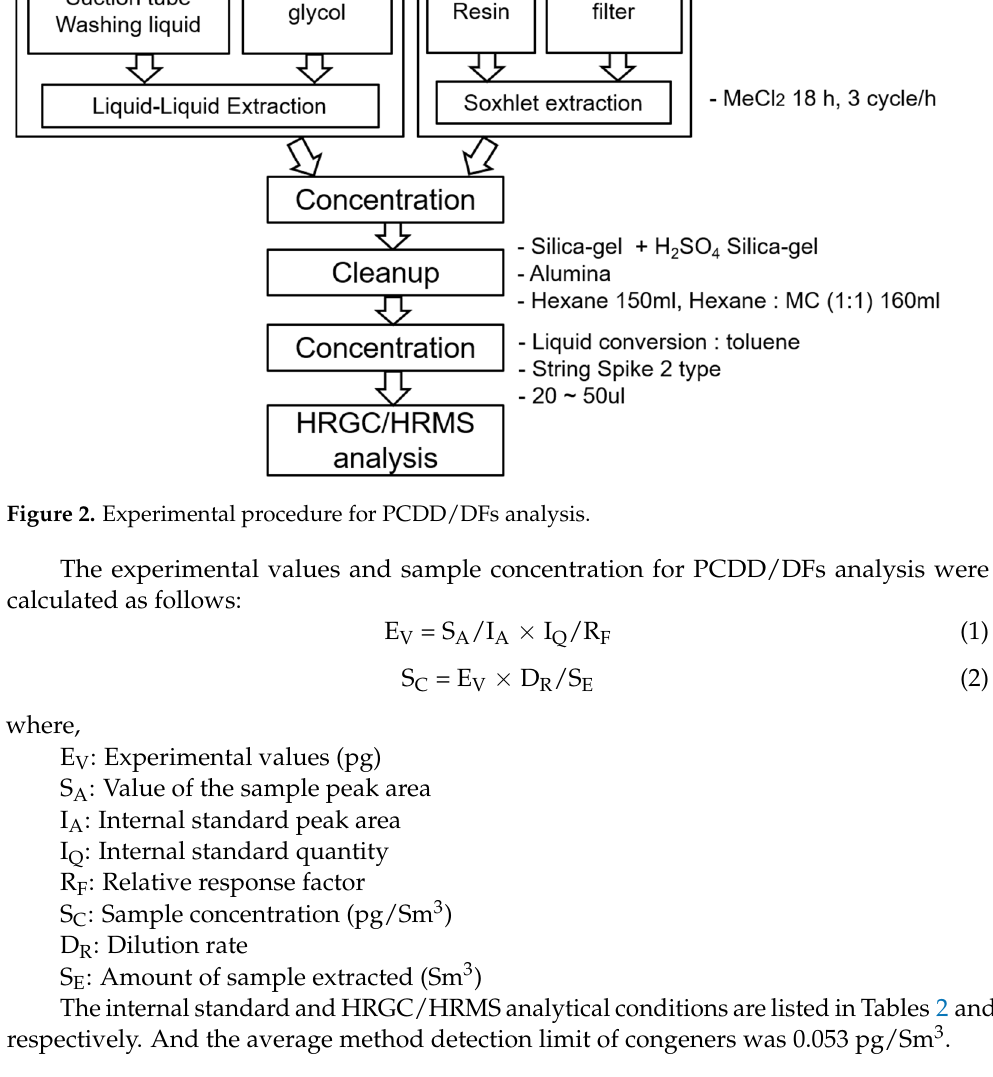
Table 2. Internal standard materials for PCDD/DFs